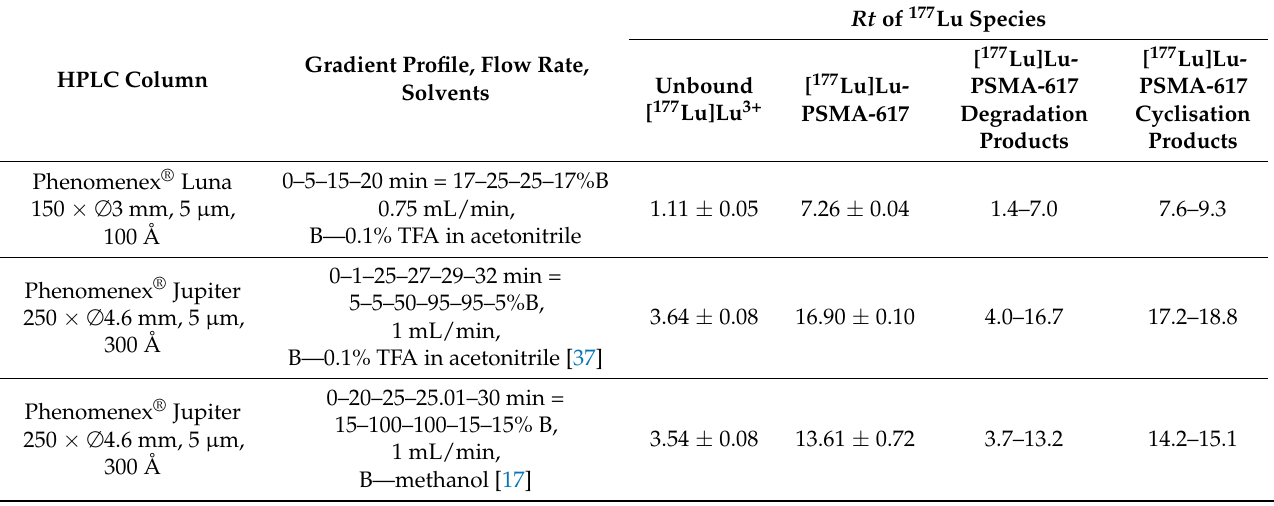
Radio-HPLC methods used to analyze the radiochemical purity